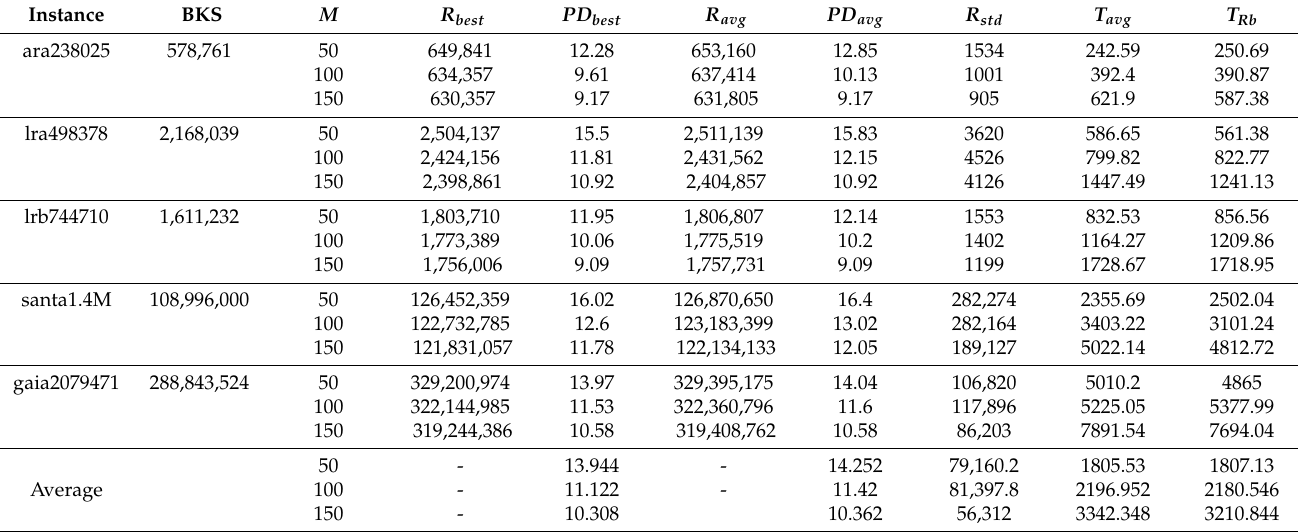
Table 8. Results obtained by the ALC_IGA with parallelization on five large instances over 2 × 10 5